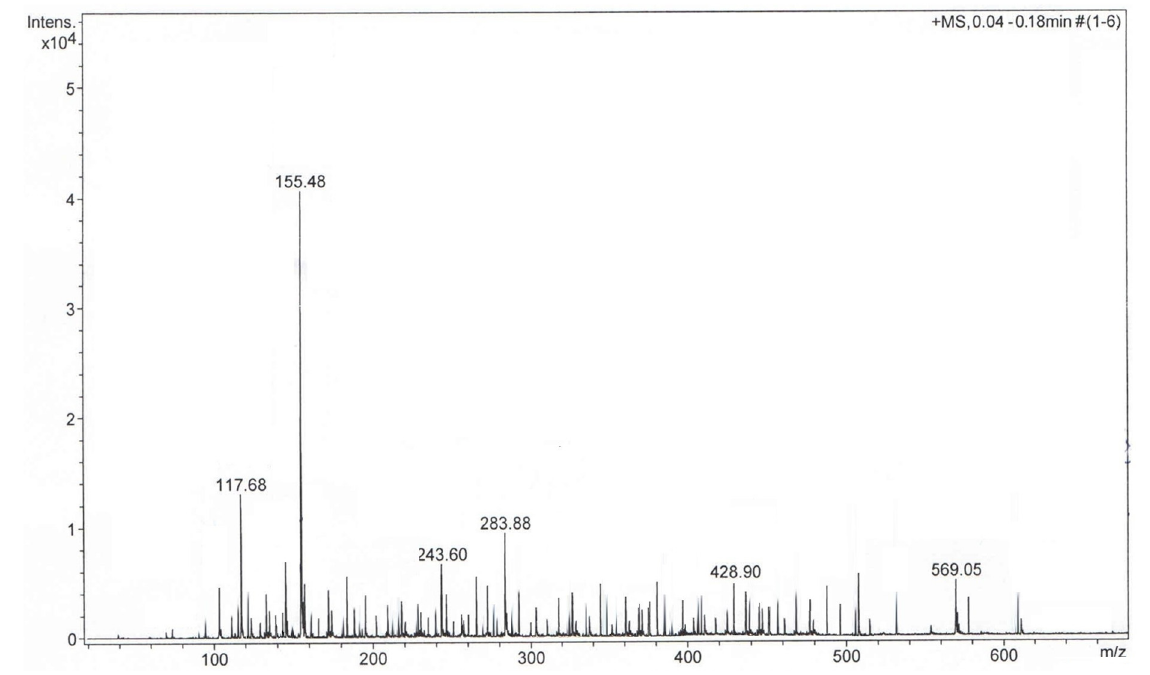
Figure 2. Positive ion mode MS-TOF of Artemisia annua sample. The identified metabolites are listed in Table 2 and classified according to their m/z ratio (mass-to-charge-ratio) (theoretical and measured), chemical name and formula and the related literature. Table 2. Phytoconstituents identified in Artemisia annua sample through MS